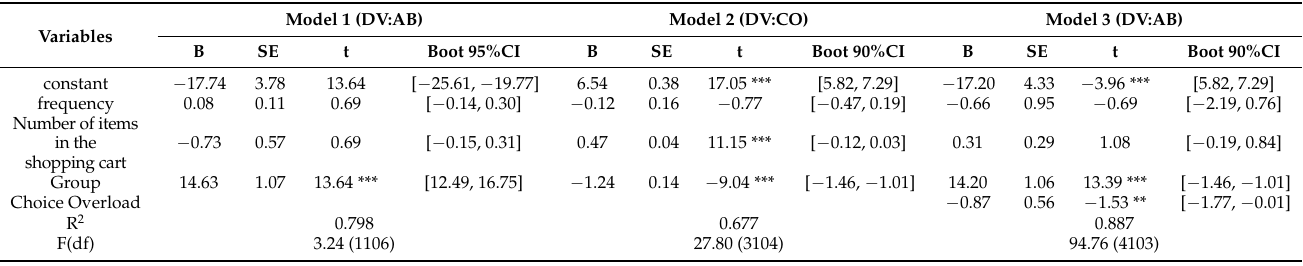
Table 7. Regression